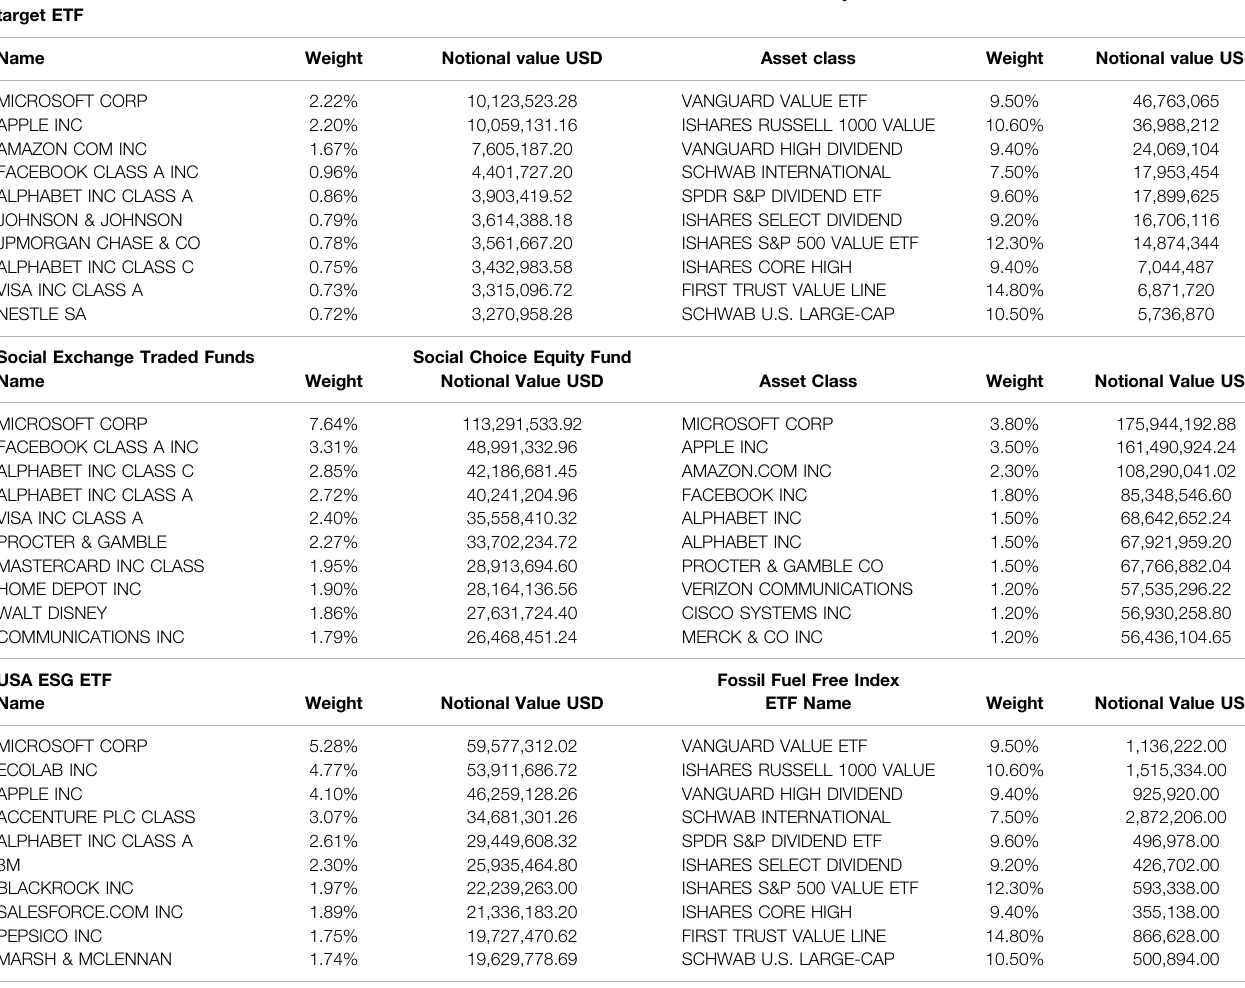
TABLE 1 | Sample funds